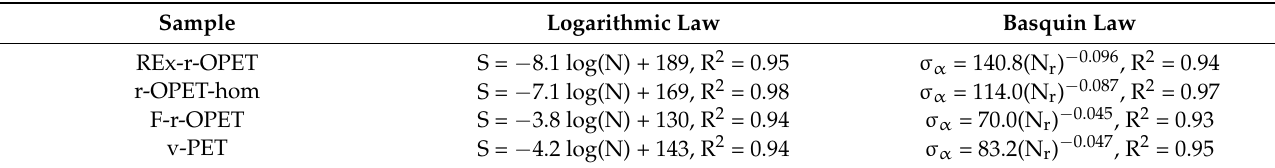
Table 2. Relationships between applied stress amplitude and fatigue life by modelling.